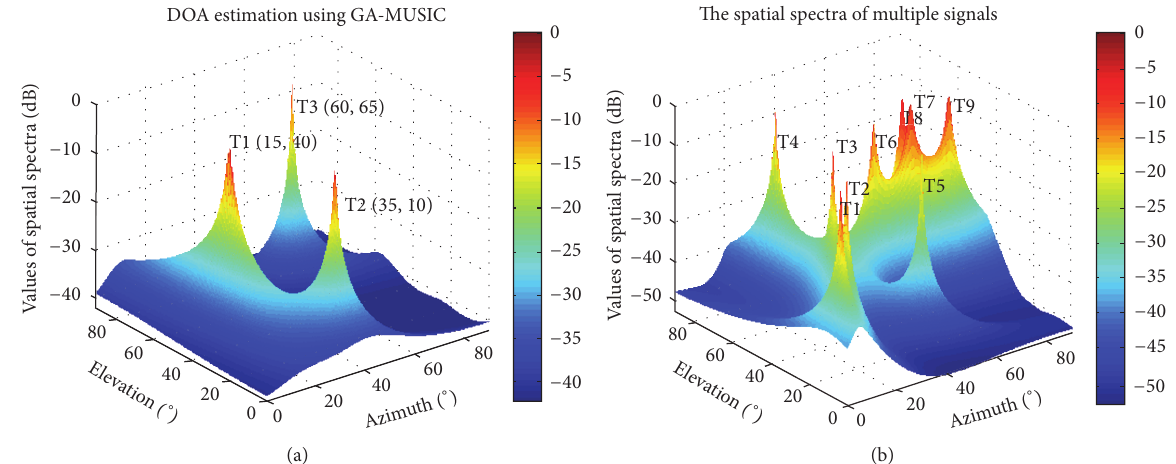
Figure 7: The performance of GA-MUSIC algorithm: (a) DOA estimation using GA-MUSIC and (b) the spatial spectra of multiple signals.